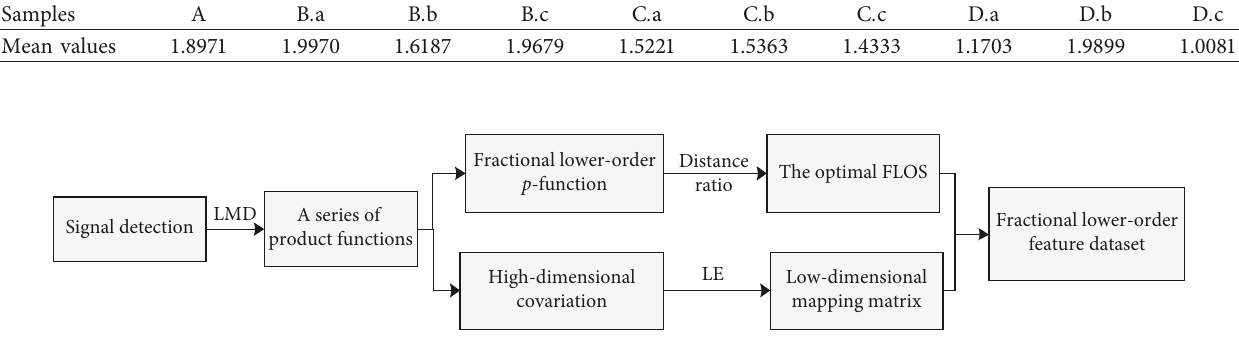
( t ) . (a) Normal A. (b) Rolling ball B . a. (c) Rolling ball B . b. (d) Rolling 1